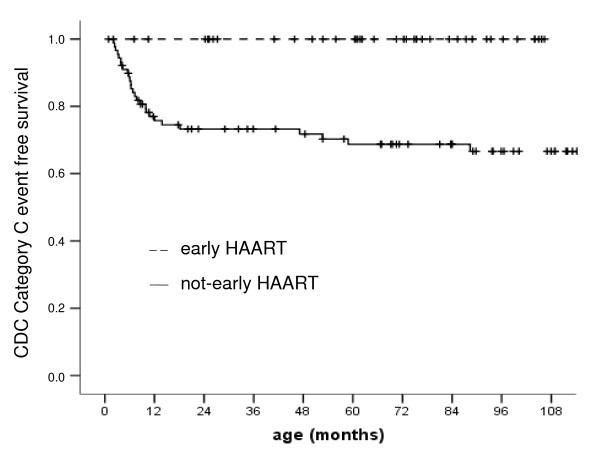
CDC Category C event-free survival in children receiving early (- - - dotted line) and not-early HAART (--- solid line). early HAART 40(0) 38 (0) 36(0) 35(0) 33(0) 31(0) 20(0) 14(0) 8(0) 1(0) Patient number (clinical event number). not-early HAART 91(20) 62 (3) 55 (0) 51(1) 49 (2) 44 (0) 38 (0) 34(1) 27(0) 22(0) Patient number (clinical event number).